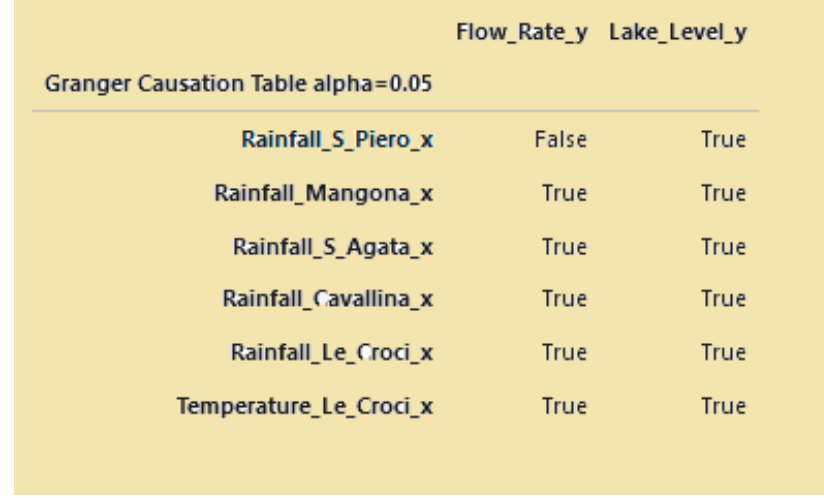
Figure 4. An example of the Granger Causality test (Bilancino-Lake).